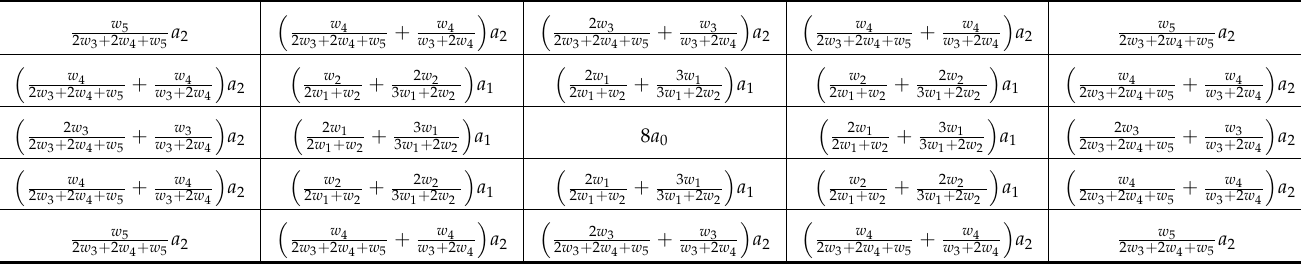
The 3 × 3 masks in eight directions (0 ◦ , 45 ◦ , 90 ◦ , 135 ◦ , 180 ◦ , 225 ◦ , 270 ◦ , and 315 ◦ ) are obtained, and the 5 × 5 masks in eight directions are extended by the 3 × 3 masks with adding zero centered around the target pixel, and then the 5 × 5 masks in eight directions are stacked to obtain the new 5 × 5 mask, as illustrated in Table 3. Table 3. The 5 × 5 spatial domain fractional differential